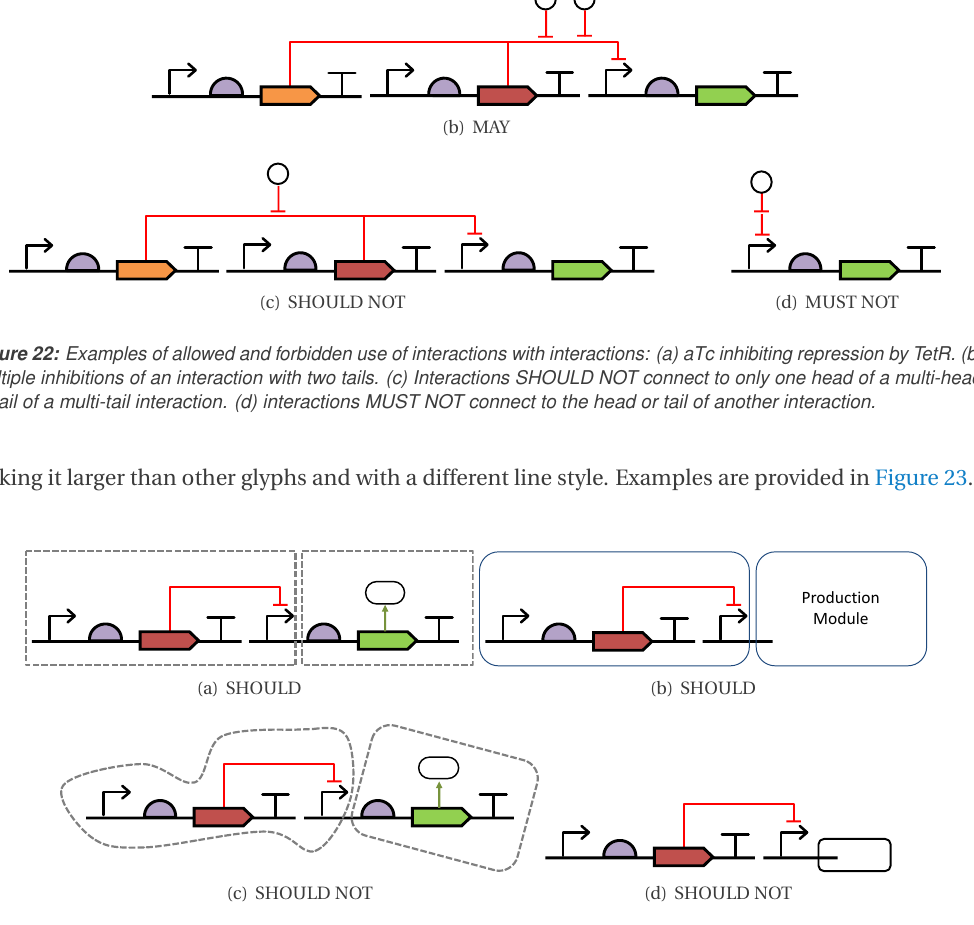
Figure 23: Examples of recommended and problematic subsystem boundaries: (a) two subsystems with visually distinct rectangular borders, (b) shows the same subsystems but with rounded rectangles and the second being a “black box” subsystem with no internal structure shown, (c) shows subsystems with non-rectilinear borders, and (d) shows a black-box subsystem that is not visually distinct from a sequence feature glyph.